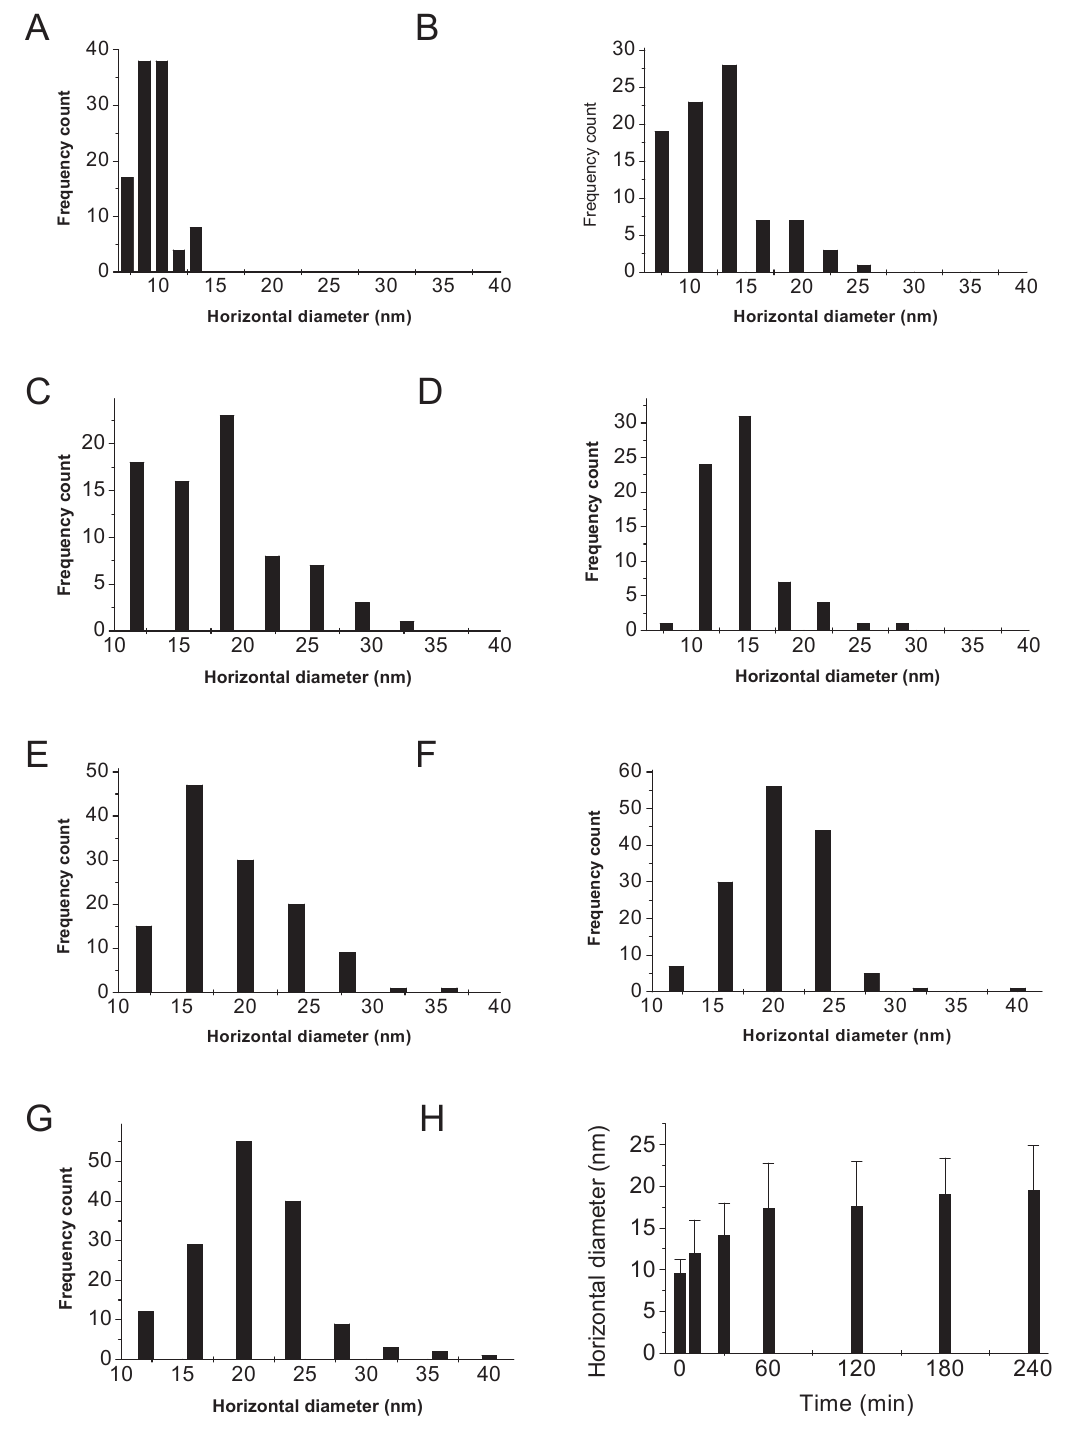
Figure 4. Changes in horizontal diameters of tau at different time intervals in 0.1% formaldehyde solution. The frequency counts of the horizontal diameters of tau protein at different incubation time ( A–G ) are based on the AFM images shown in Figures 3A–G, respectively. The mean values are summarized in H .